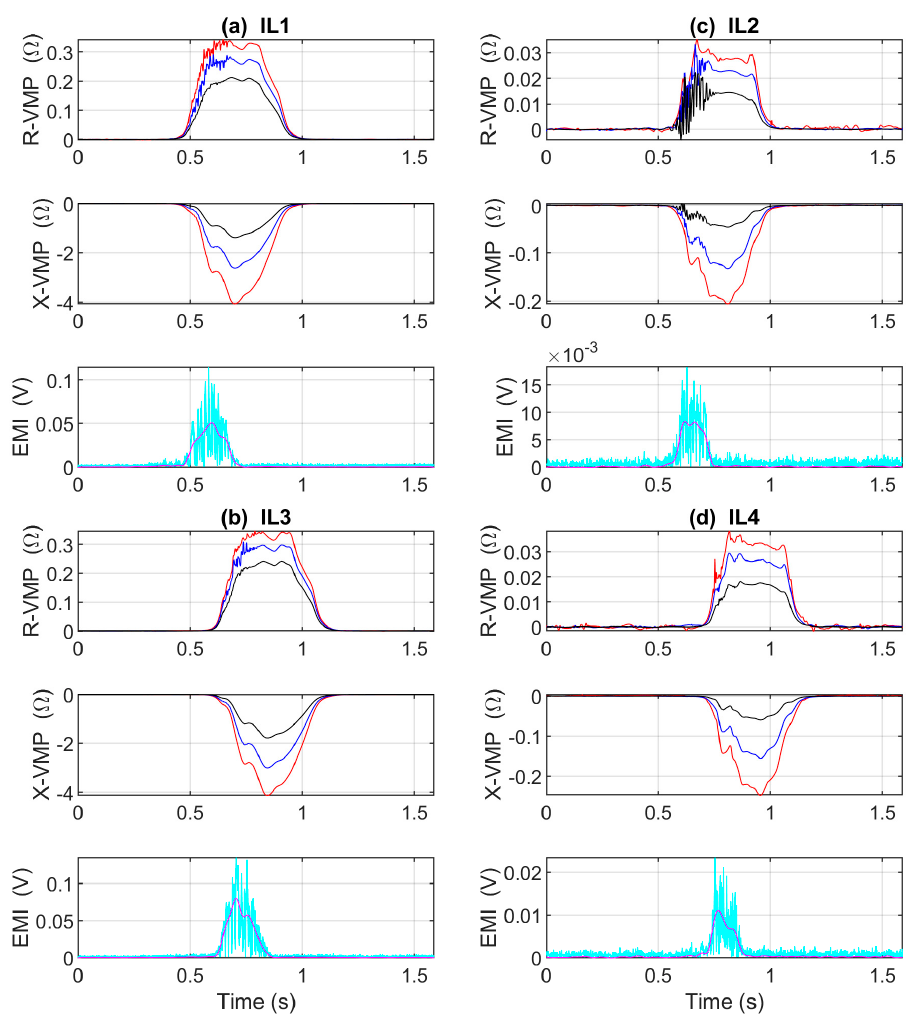
Figure A2. VMPs and EMIs of Hyundai i30 after denoising process. The rest of the description is the same as in Figure 2.